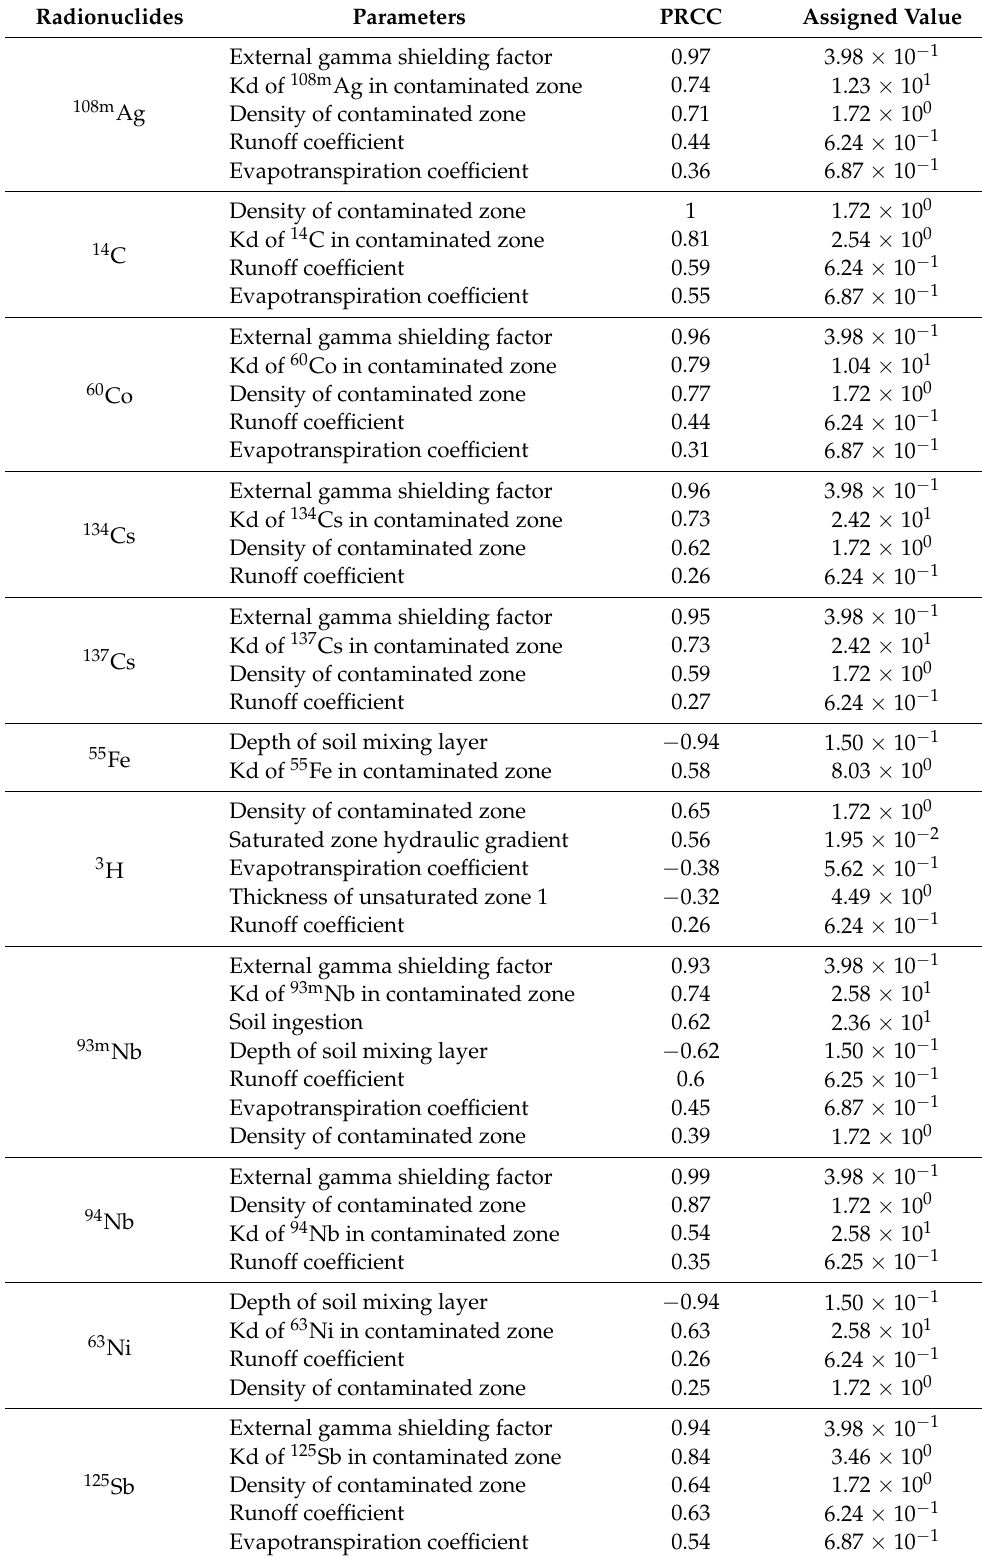
Table A2. Partial rank correlation coefficient (PRCC) and assigned value for each radionuclide derived in this